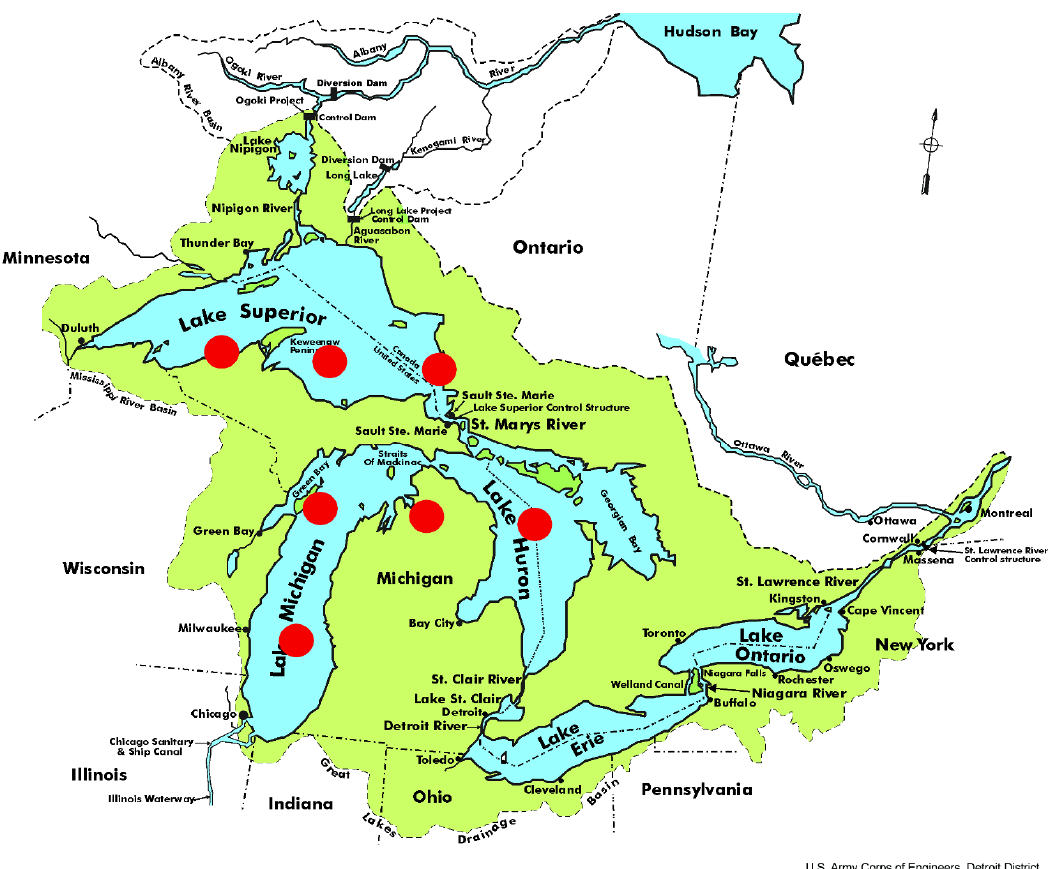
Figure 2. Grid locations considered for regional precipitation estimate using NCEP CPC daily gridded precipitation data. Original image obtained from NOAA/GLERL.